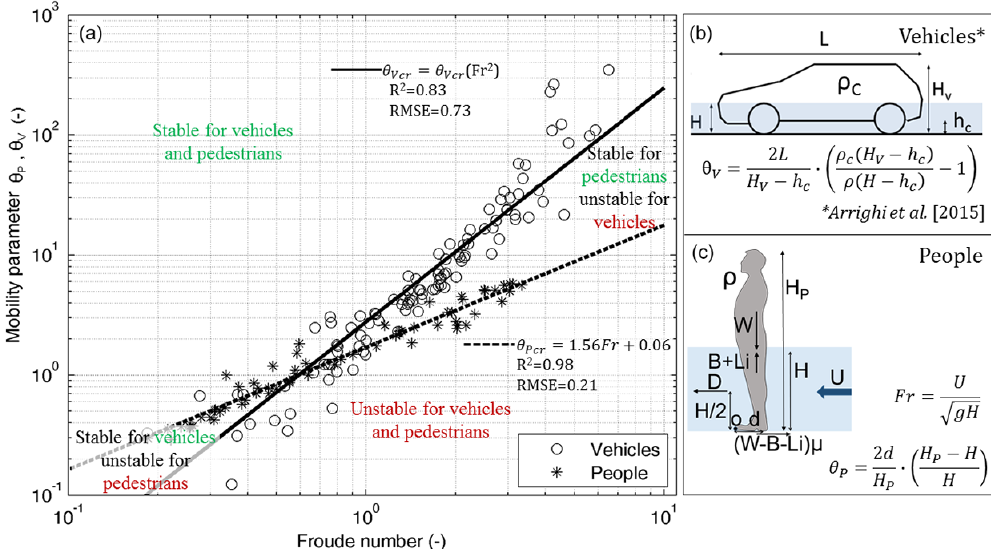
Figure 8. Comparison between dimensionless mobility parameter for people instability in flood flows θ P and dimensionless mobility parame- ter for incipient motion of flooded vehicles (Arrighi et al., 2015) (a) , definitions of the parameters and geometric sketches for vehicles (b) and people (c) . The black continuous and dashed lines represent the critical dimensionless incipient motion curve for flooded vehicles and people